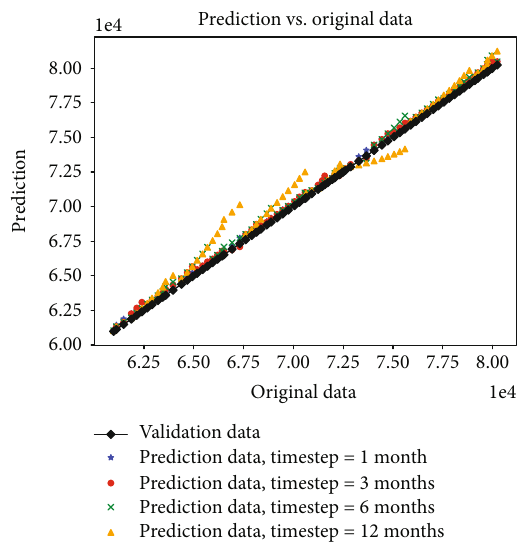
Figure 6: Comparisons between cumulative oil production data with predicted data as the function of timesteps in Bakken formation. The scale of the y -axis is in an order of 10 4 .